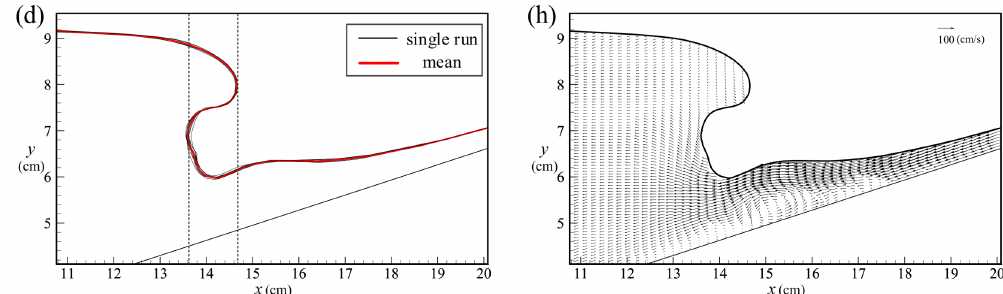
Figure 4. Repeatability tests of instantaneous free surface profile and velocity field of solitary wave over sloping beach at t = 1.048 s ( T = 11.60): ( a – c ) instantaneous images taken for three distinct runs; ( d ) comparison of ten instantaneous free surface profiles with ensemble-averaged one; ( e – g ) instantaneous velocity field corresponding to ( a – c ), respectively; and ( h ) ensemble-averaged velocity field acquired from ten repeated runs (Case 1). Note that the flow structures shown are not generated by breaking wave, but by hydraulic jump with a “backward” motion (also see Figure 5b).